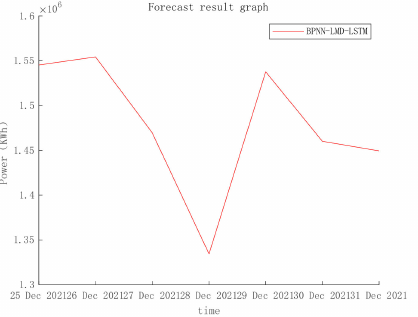
Figure 8. Sum of PF.